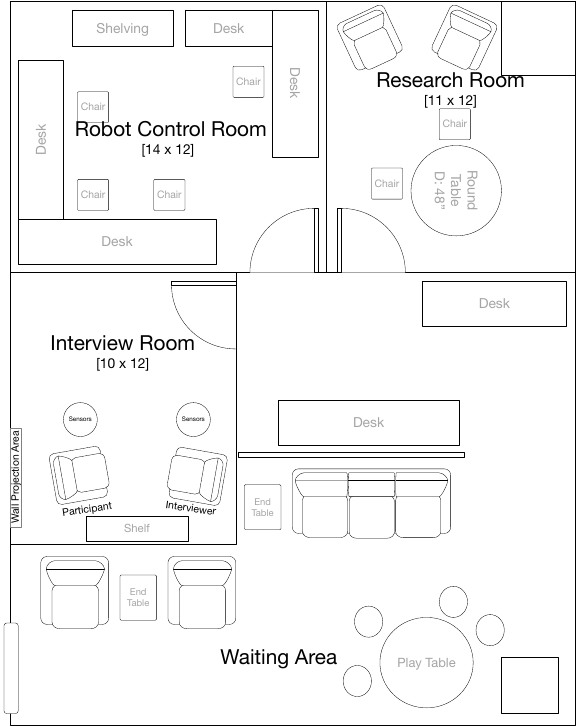
Figure 2: Physical layout of the study space used for conducting forensic interviews. (Room dimensions in feet.)